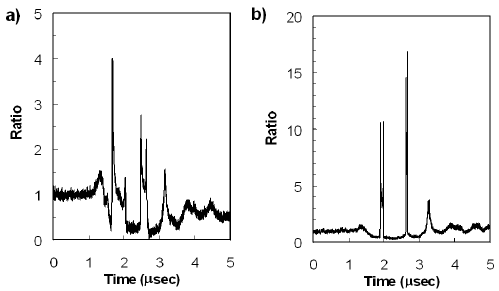
FIG. 7. Beam current amplification factor, (a) as measured using a Faraday cup upstream of the energy analyzer, and (b) as simulated using the WARP code. The Faraday cup had a finite aperture as well as time resolution and was unable to measure the full beam bunch current variations predicted by the simulation.